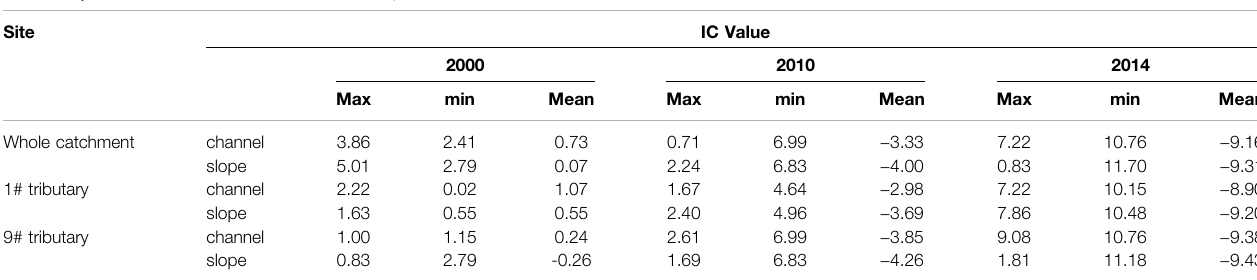
TABLE 3 | IC values in the channels and on the